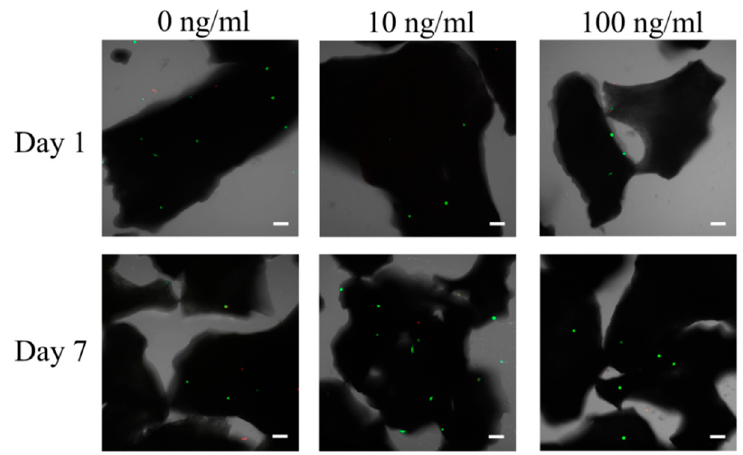
Figure 3. Live, dead, and merged images of stem cells on Days 1 and 7 Scale bar indicates 100 µm (original magnification: ×50).